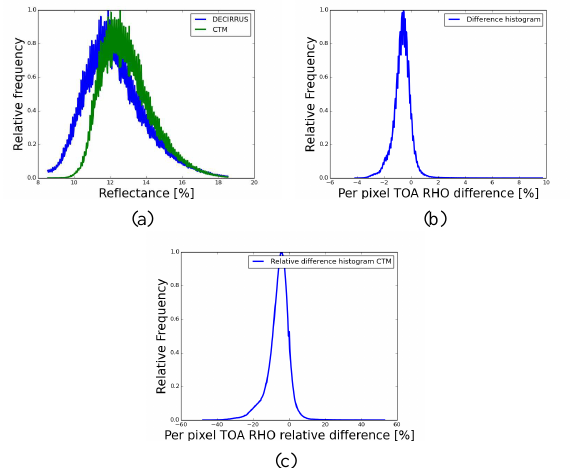
Figure 2: The Landsat-8 1.38 µ m and the CTM decirrus results (Band 3 TOA reflectance): a) histograms, b) difference his- togram, c) relative difference histogram.